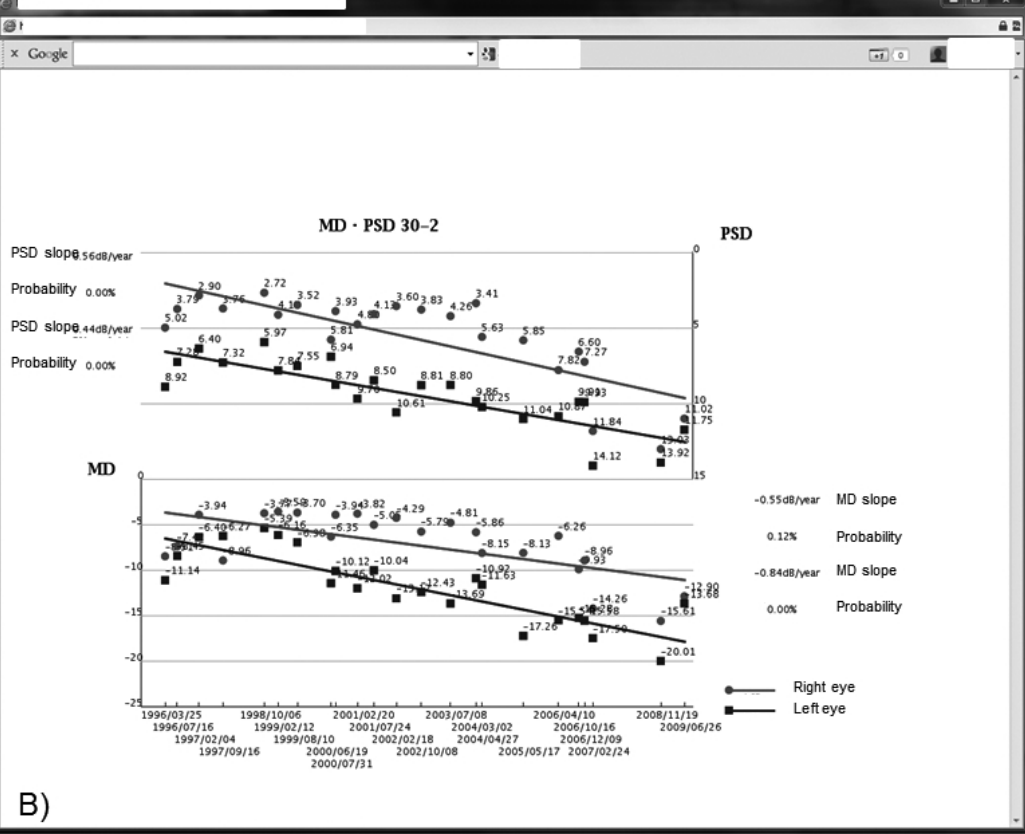
Figure 4. The PSD (upper graph) and MD slopes (lower graph) show the possibility of glaucoma progression with a probability analysis. MD: mean deviation, PSD: pattern standard